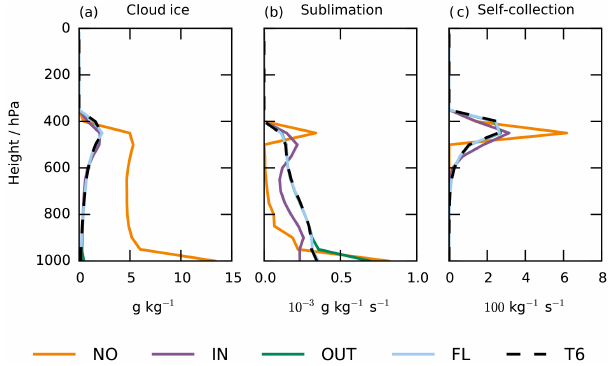
Figure 5. Simulations as in Fig. 4 but for vertical profiles at equilib- rium, evaluated after 12h of the simulation. (a) cloud ice, (b) subli- mation rate and (c) self-collection